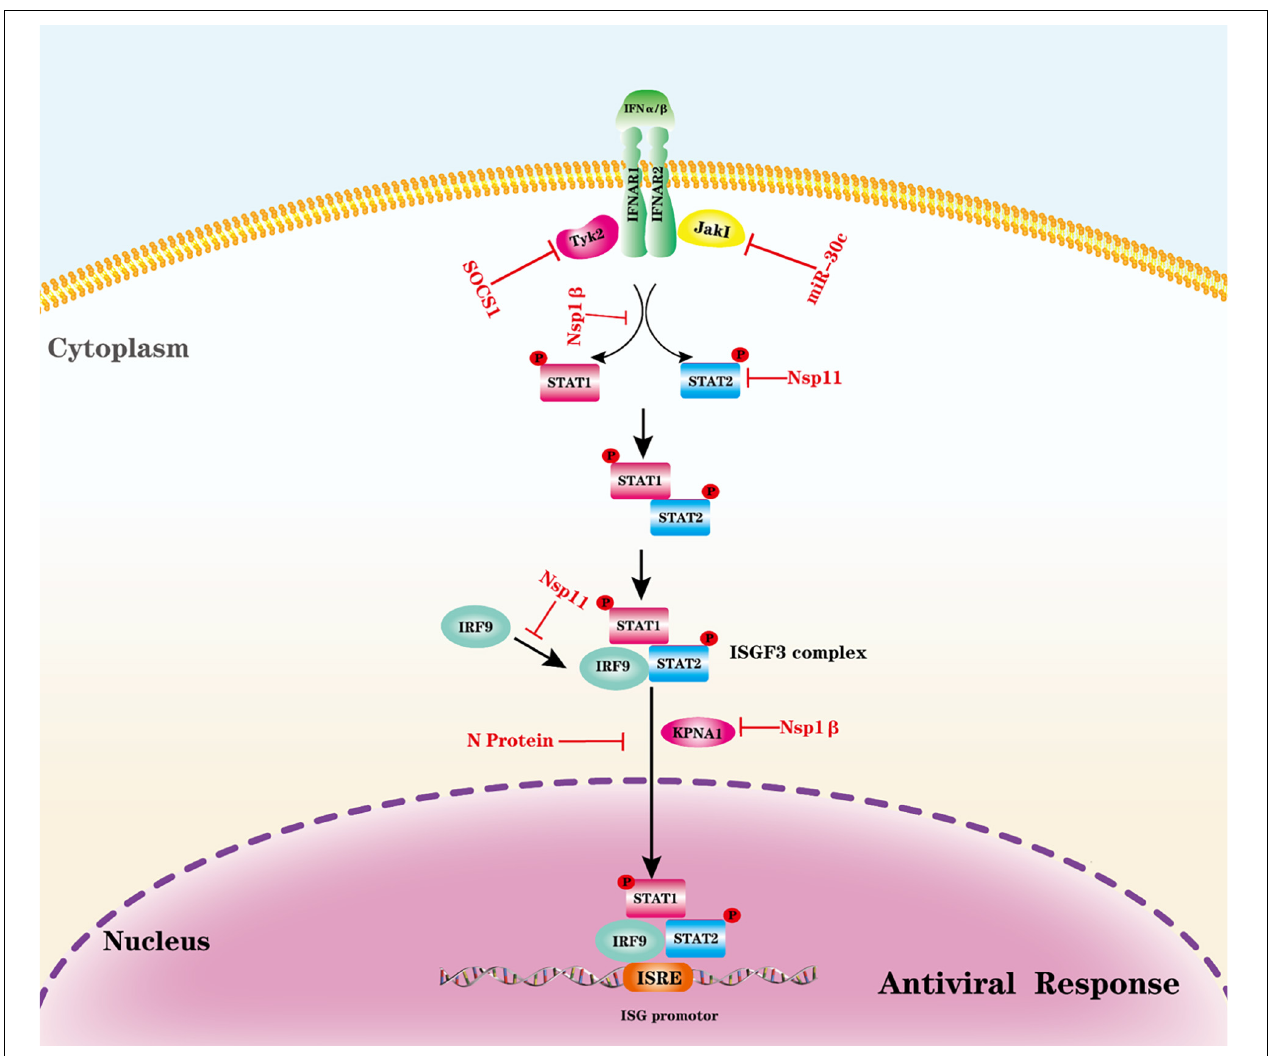
FIGURE 2 | Evasion of the IFNAR-JAK-STAT signaling pathway by PRRSV. The antiviral activities of IFN-I and other cytokines are initiated by binding to their receptors to trigger a signaling cascade. Viral proteins from PRRSV interact with indicated adaptors to block signal transduction. P, phosphate.